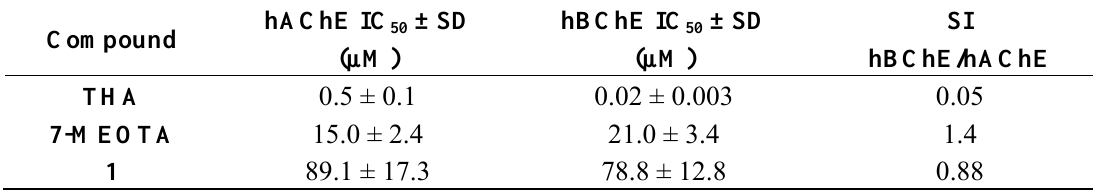
Table 1. IC values of tested compound and 50